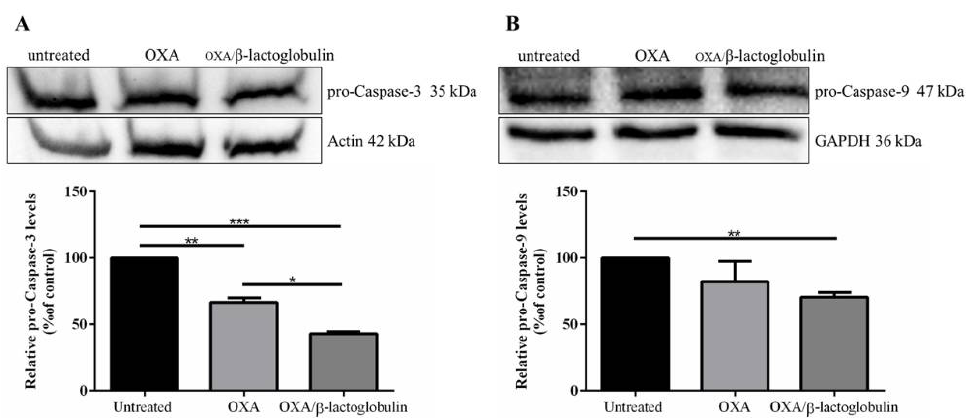
Figure 5. Apoptosis activation in A431 cells incubated with OXA or OXA/ β -lactoglobulin. Cells were incubated in the presence of each molecule at the concentration needed to reach the IC 50 value. After a 72 h incubation, cell extracts were prepared and subjected to Western blotting analysis using anti- pro-caspase-3 antibody ( A ), or anti-pro-caspase-9 antibody ( B ). Actin or GAPDH were used as in- ternal standards. The relative densitometric analysis is reported below. Values are given as means ± SD ( n > 3). * indicates p < 0.05, ** indicates p < 0.01, *** indicates p < 0.005.